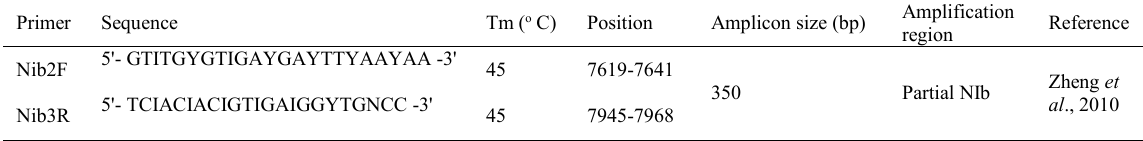
Table 2. Characteristics of primer pairs used for this study to amplify partial Nib region of potyvirus isolates. Primer